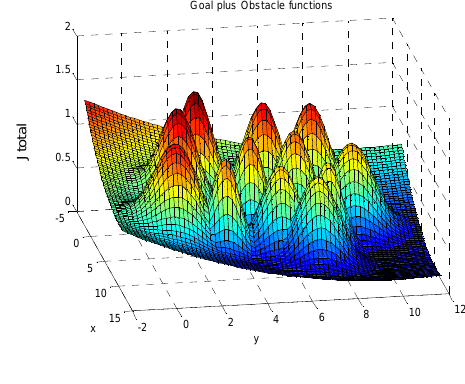
Fig. 7. Cost function for case